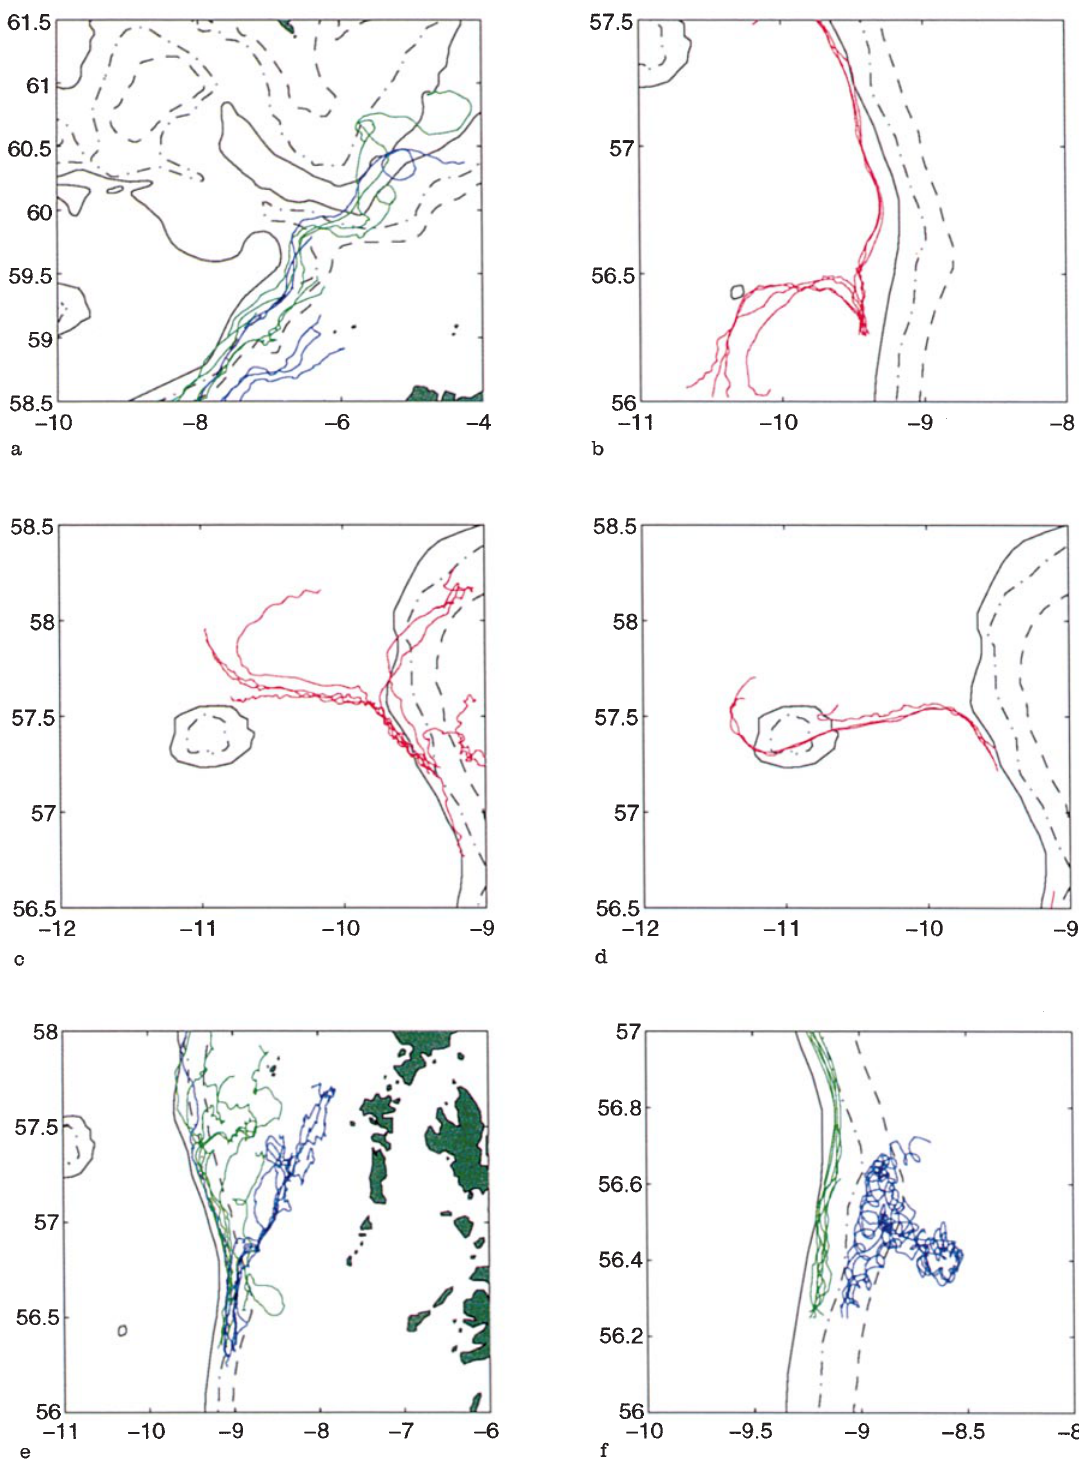
Fig. 11a–f. Dispersive events from the slope current during winter in the left column ( a, c, e ) and summer in the right ( b, d, f ). The deployment circles are coloured as in Figs. 3–4. a All winter drifters through days 25–35 near the Wyville Thomson Ridge, where the drifters are deflected into the Faeroe-Shetland Channel. b Circle 3 summer drifters immediately after deployment, four drifters enter a southward drifting cyclonic eddy at the Barra Fan. c, d Show the